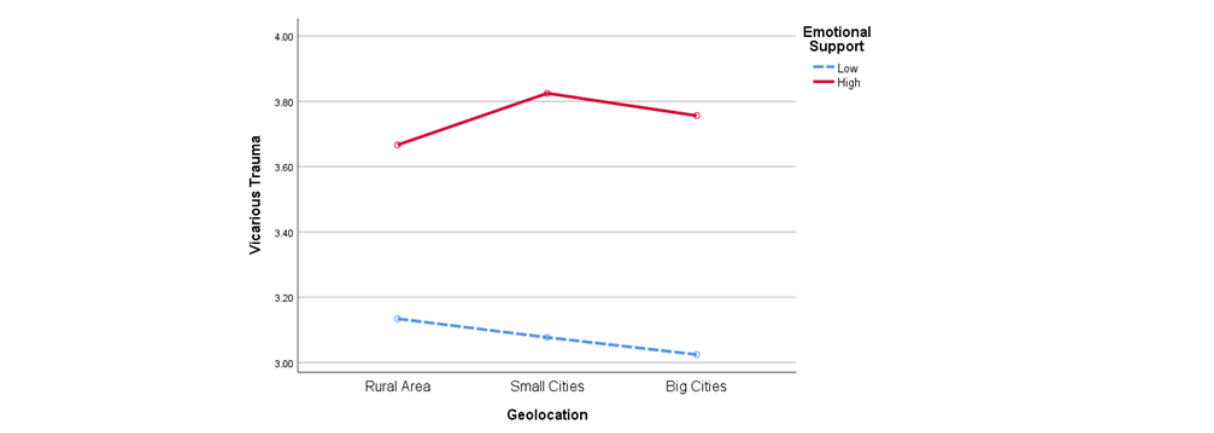
Figure 2. Interaction between geolocation and emotional support for vicarious trauma.